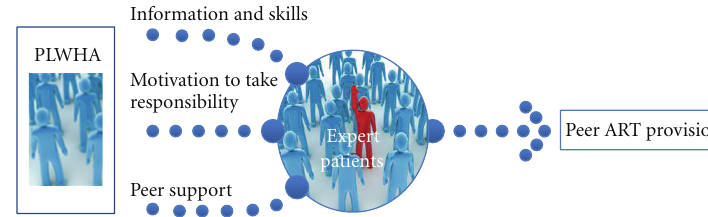
Figure 1: Conceptual framework: elements required to reinforce PLWHA to become expert patients.